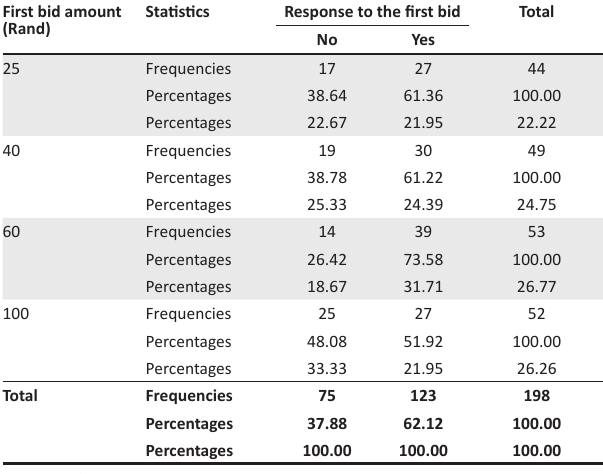
TABLE 5: Response distribution for the first bids.